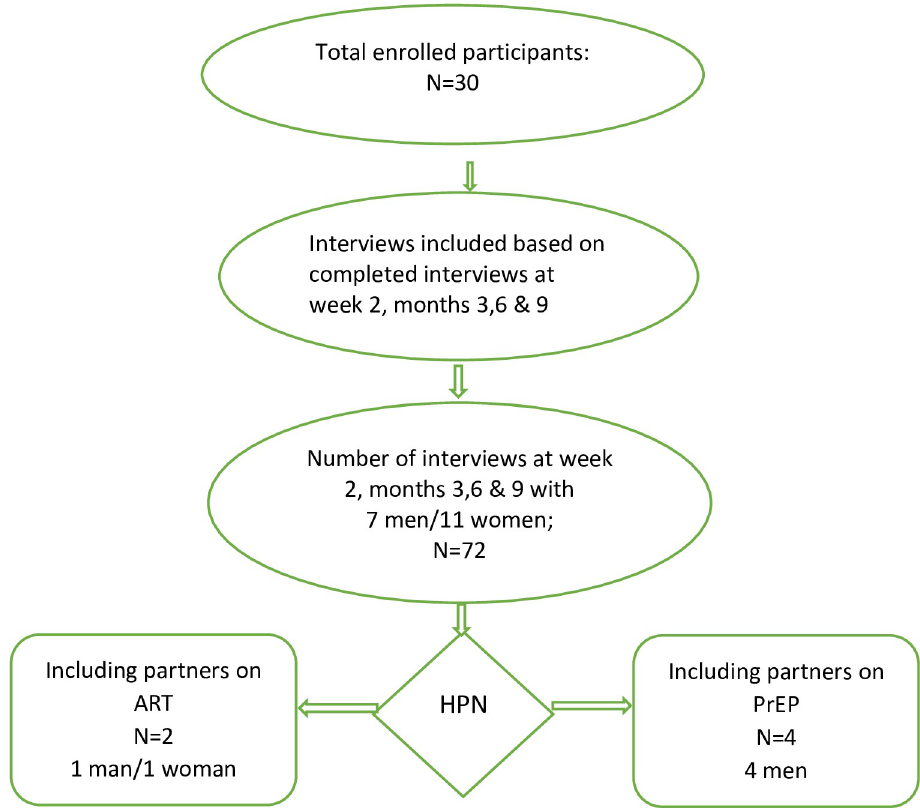
Fig 2. Flow diagram of in-depth interviews with index participants at enrolment, month 3,6, and month 9, including VL measurements at week 6 and month 6; and in-depth interviews with partners.